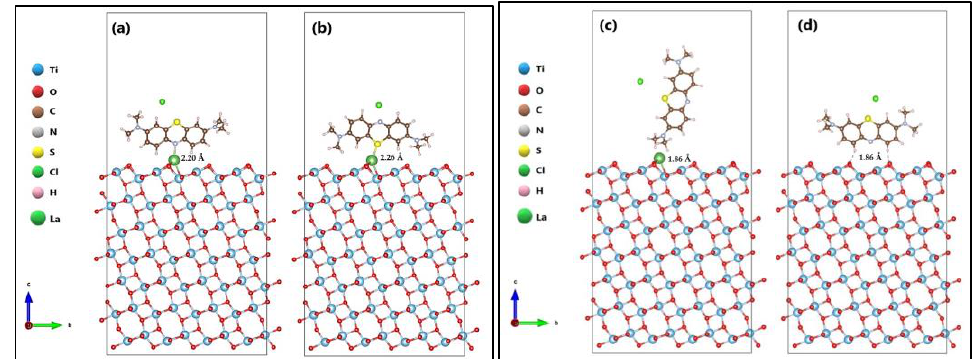
Figure 7. Methylene blue (MB) molecule in ( a ) P N , ( b ) P S , and ( c ) P V orientations on the La/TiO 2 surface, and ( d ) P H orientation on the TiO 2 surface.